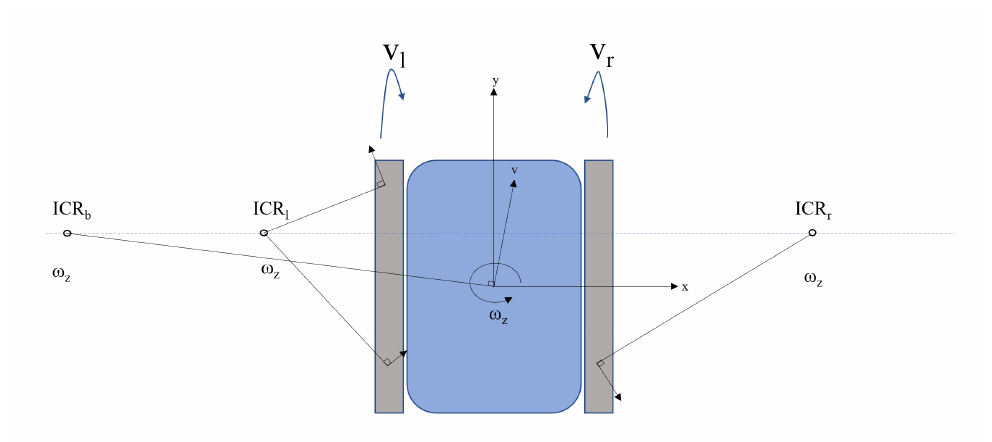
Figure 4. The locations of the ICRs as the robot makes a circular turn with angular and linear velocities.